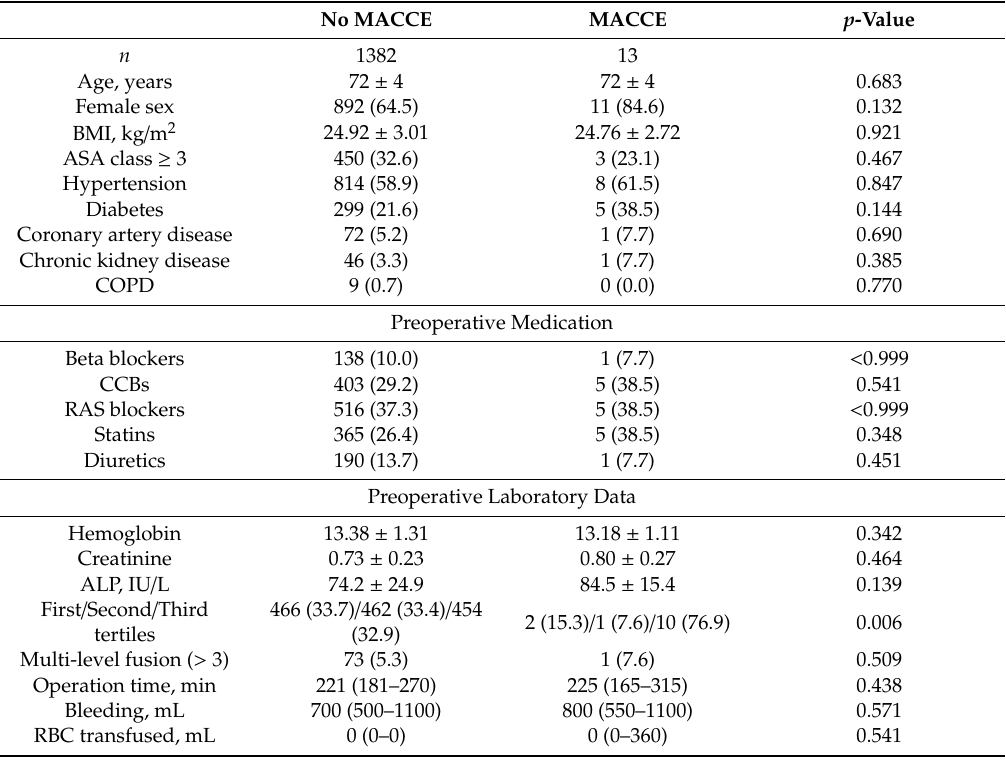
Table 3. Intergroup comparison of baseline characteristics and operative data based on the incidence of 30-day major adverse cardiac and cerebrovascular